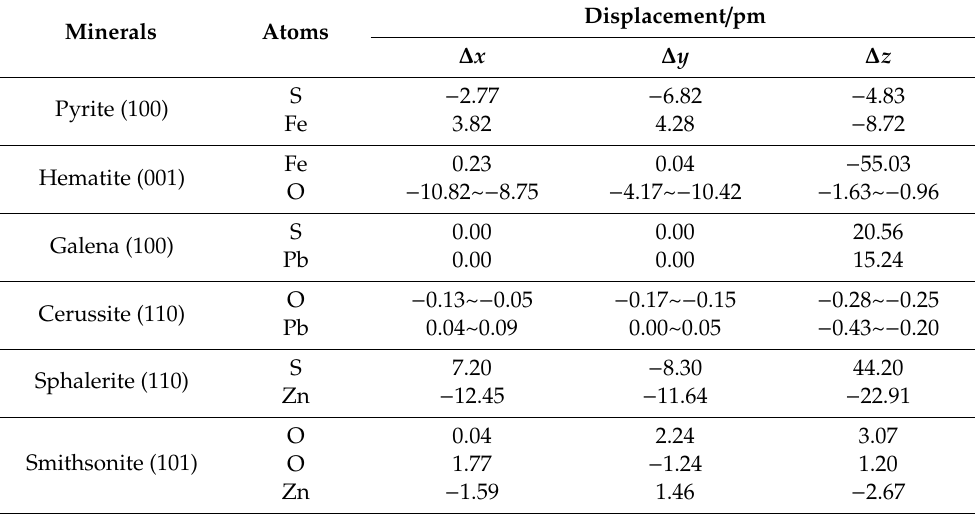
Table 2. Atomic displacements of the minerals